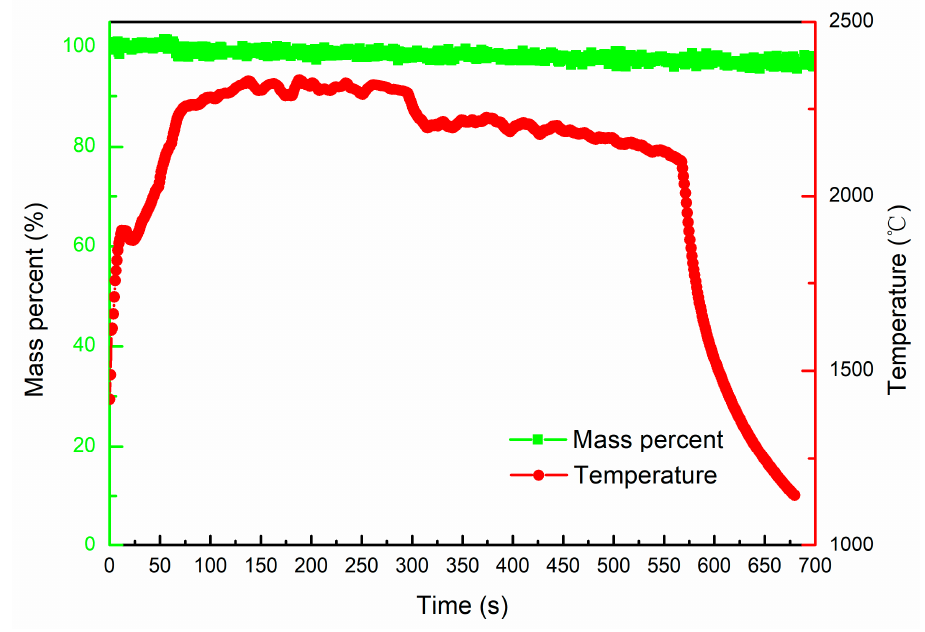
Figure 4. The vacuum evaporation of V by EBM.